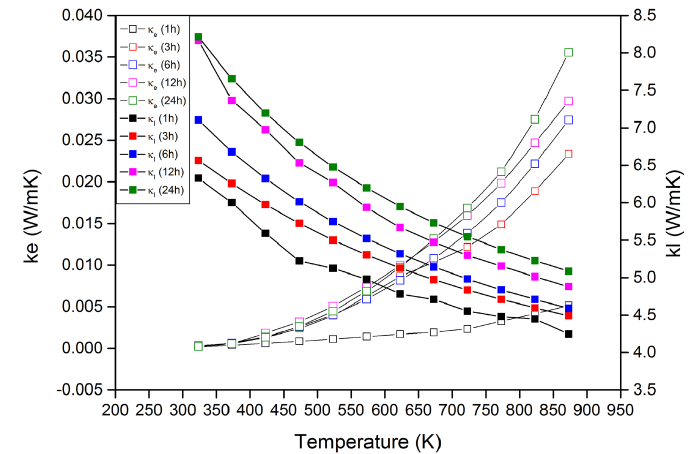
Figure 4. Electronic and lattice components of the thermal conductivity for the CMO ceramics.